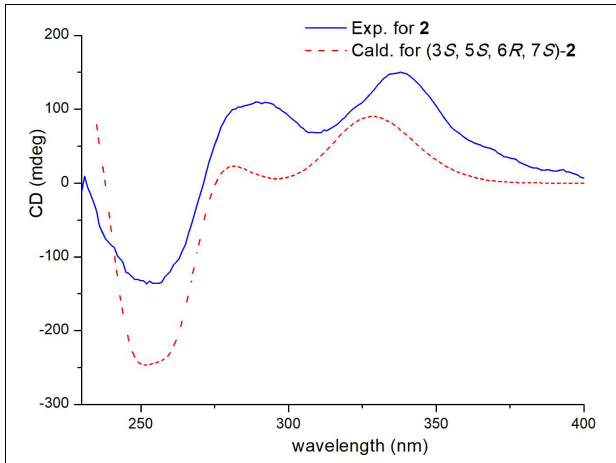
FIGURE 7 | Experimental and calculated ECD spectra of compound 2 (calcd. ECD curves with a bathochromic shift for 45 nm).